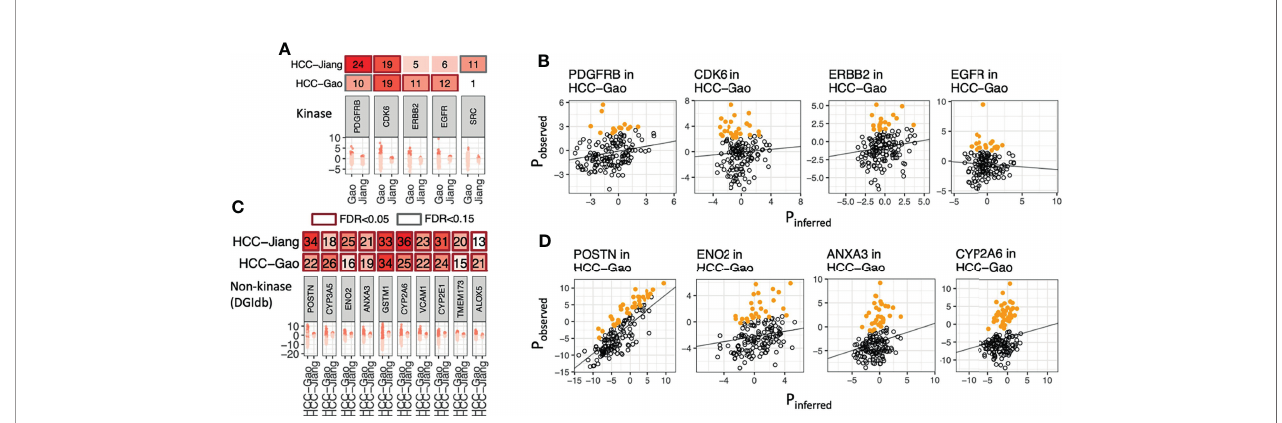
FIGURE 2 | Overexpressed kinase and non-kinase proteins detected in human HCC tumors. (A) Protein kinases showing signi fi cant enrichment of overexpression as identi fi ed by OPPTI in either primary tumor cohort. (B) Sample-level kinase overexpression in HCC-Gao cohort of the markers shown in panel A, as identi fi ed by OPPTI through the deviation of observed protein expressions (y-axis) from the background inference (x-axis) and a cutoff value (not shown). (C) Ten non-kinase proteins showing the most signi fi cant enrichment of overexpression as identi fi ed by OPPTI in either primary tumor cohort. (D) Sample-level overexpression plots of the markers shown in panel C, as identi fi ed by